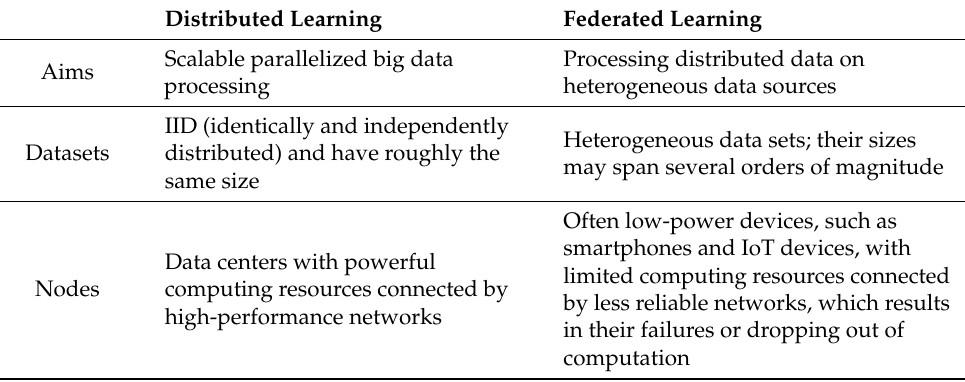
Table 1. Distributed learning vs. federated